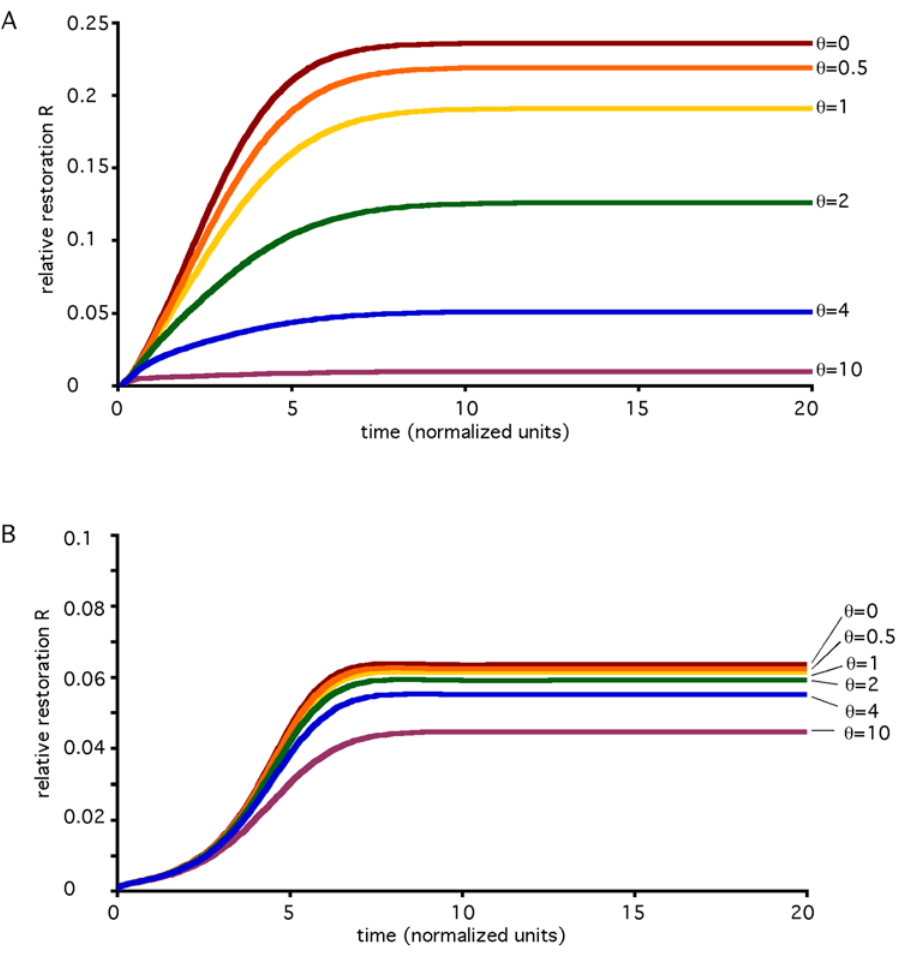
Figure 7. Effect of RdRP-mediated amplification. Each graph shows restoration versus time for numerical simulations of recursive RNAi experiments targeting Dicer. (A) gamma=1. (B) gamma=200. Within each graph, results for different values of the amplification efficacy parameter theta are given. Theta is proportional to the number of secondary siRNA molecules produced by RdRP for each targeted mRNA molecule. Modification of model equations to incorporate RdRP activity is described in Materials and Methods.